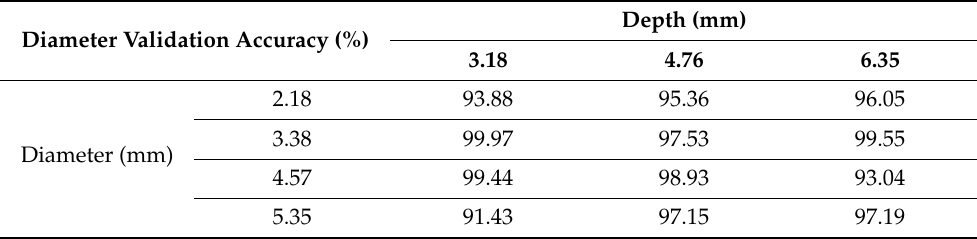
Table 14. Detailed validation accuracy of MISO ANN model for diameter prediction.